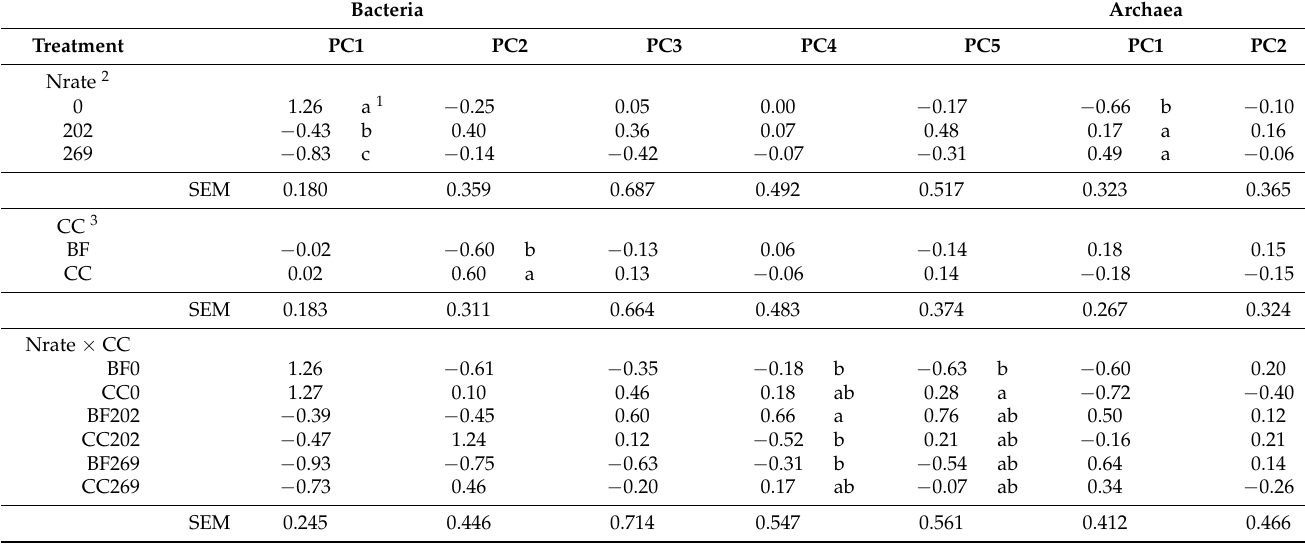
Table 2. The estimated treatment means and standard errors of the mean (SEM) of each group of principal components (PC) calculated for bacterial and archaeal indicators determined by the main effects of N fertilization (Nrate), cover cropping (CC), and their interaction. Probability values ( p -values), sample size ( n ), and degrees of freedom (df) associated with the different sources of variation from Type III Test analysis of variance results are shown